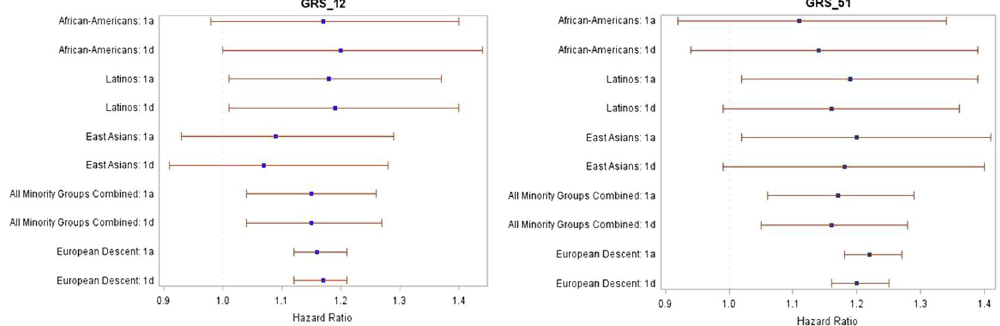
Figure 3. Forest plot for 1 SD increment of GRS in Model 1a (adjusted for PCs only) and 1d (fully-adjusted).